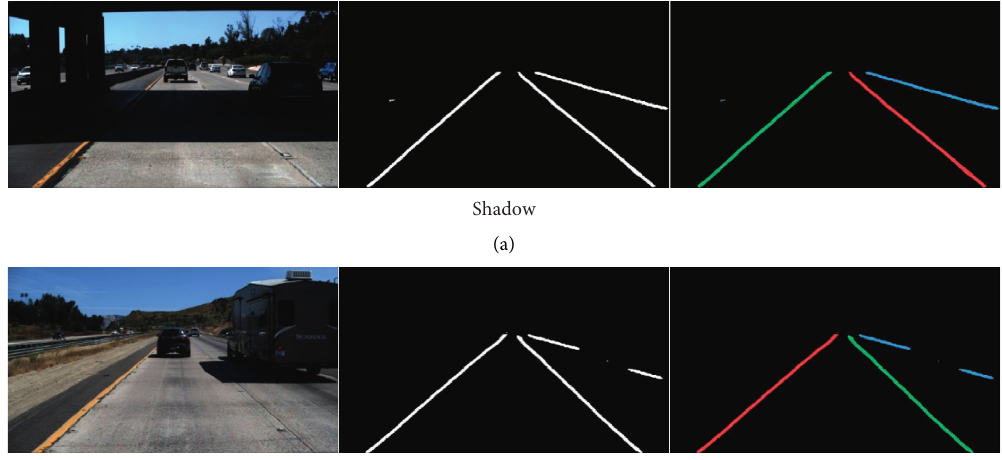
Figure 8: Network outputs. The first column denotes inputs, the second column denotes semantic segmentations, and the third column denotes instance segmentations after clustering. (a) Shadow. (b) Lane markings are severely worn and blocked by vehicles.